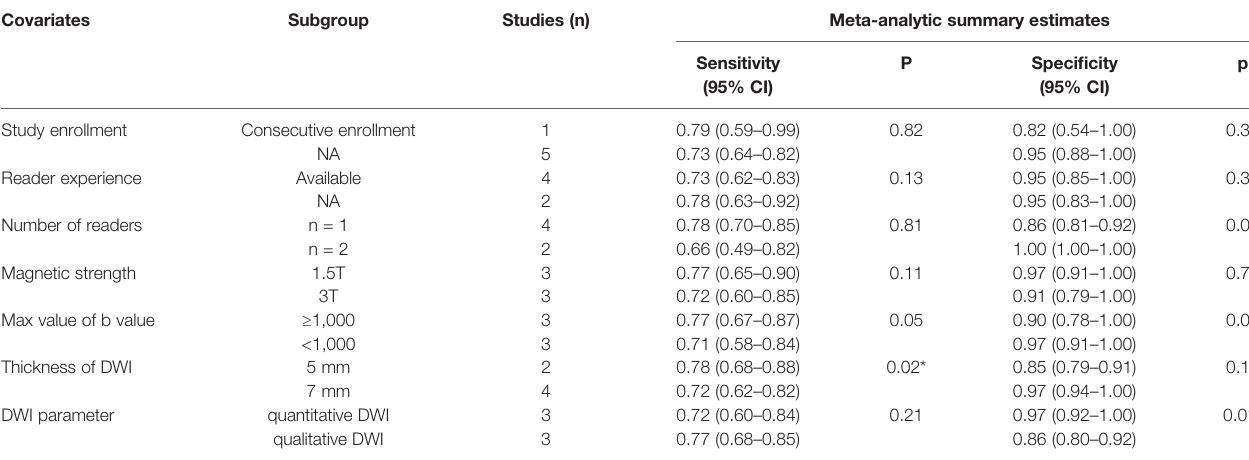
TABLE 3 | Results of the meta-regression analysis of DWI for discriminating benign and malignant IPMN.